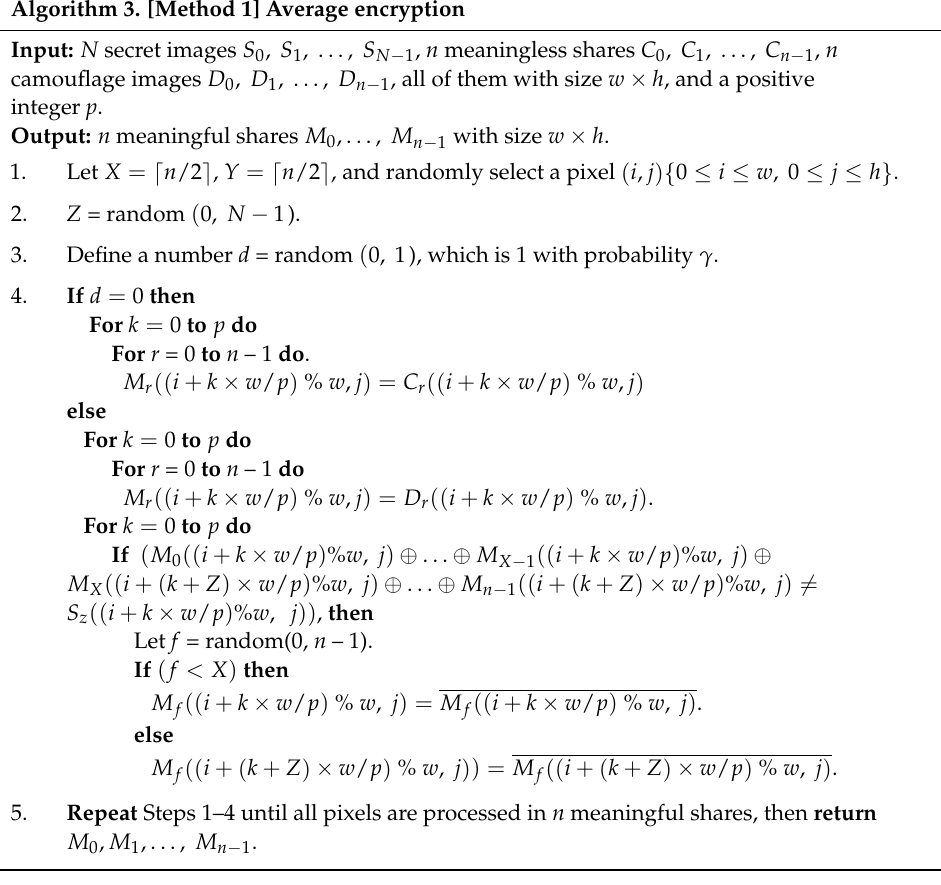
Algorithm 3. [Method 1] Average